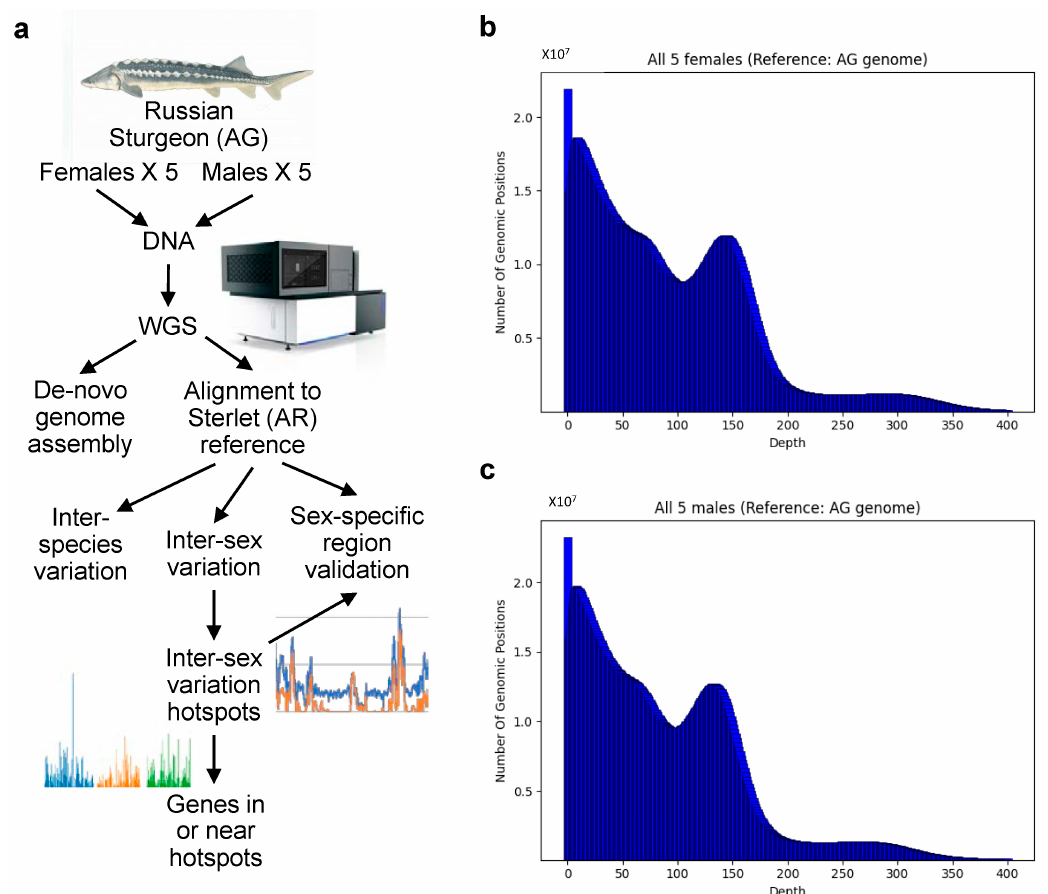
Figure 1. ( a ) Scheme of study; ( b , c ) Distribution of sequencing depth over all genome positions when reads are aligned to AG genome; ( b ) female samples combined and ( c ) male samples combined. Distributions for individual samples and for all samples combined can be found in Figure S1.